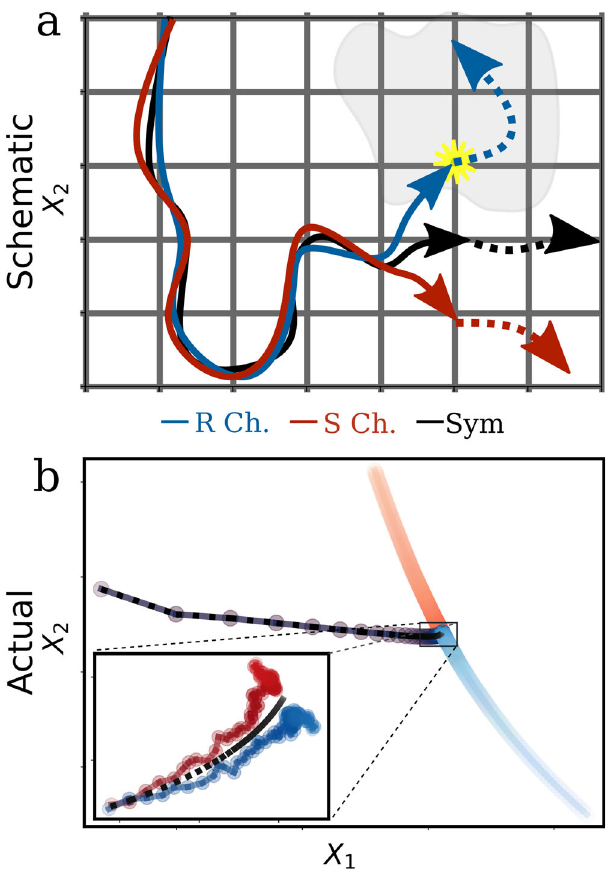
Fig. 5 Trajectory perspective. a A generalized trajectory perspective of a chirality-breaking event for the R (left) and S (right) system channels. Here, X X 1 and 2 represent arbitrary state space coordinates, and the shaded area indicates special state space con fi gurations fi nely matched to strong driving from the environment. Yellow asterisk indicates the point where a random fl uctuation in the R trajectory (blue) intersects with the special high driving region and triggers a system bifurcation (seen as diverging dashed lines in both R and S trajectories). This intersection event is random and equally likely for both channels upon system restart. b The projected trajectory of the chiral symmetry-breaking model of Fig. 2, following a singular value decomposition analysis of the corresponding symmetric trajectory. Axes represent the two main eigenvectors (i.e., X i ) capturing ∼ 96% of system variation. Time traces are encoded by the respective color from dark to light during a period of t = 2 − 350 (s). Inset depicts a zoomed time trace near bifurcation